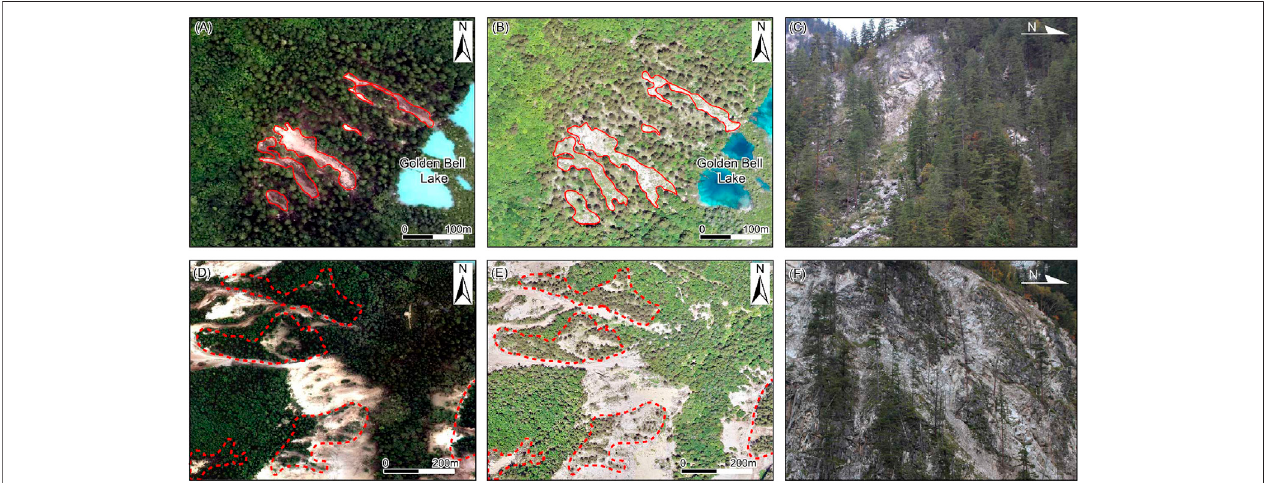
FIGURE 10 | Expansion of vegetation degradation (A) Coseismic landslides in 2017 (B) Hidden damage of landslide appears in 2020 (C) Field photo showing the damage caused by coseismic landslides (D) Vegetation damaged by the coseismic landslides in 2017 (E) Vegetation degradation on landslides in 2020 (F) Field photo showing the vegetation degradation caused by landslides.